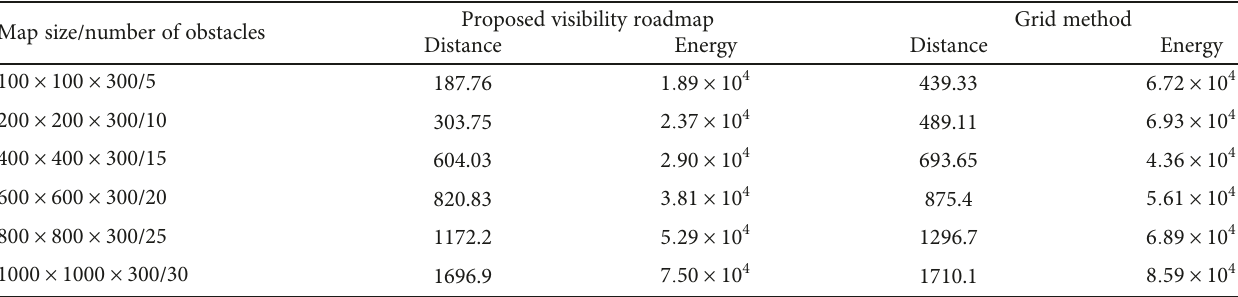
Table 5: Simulation results based on map size.